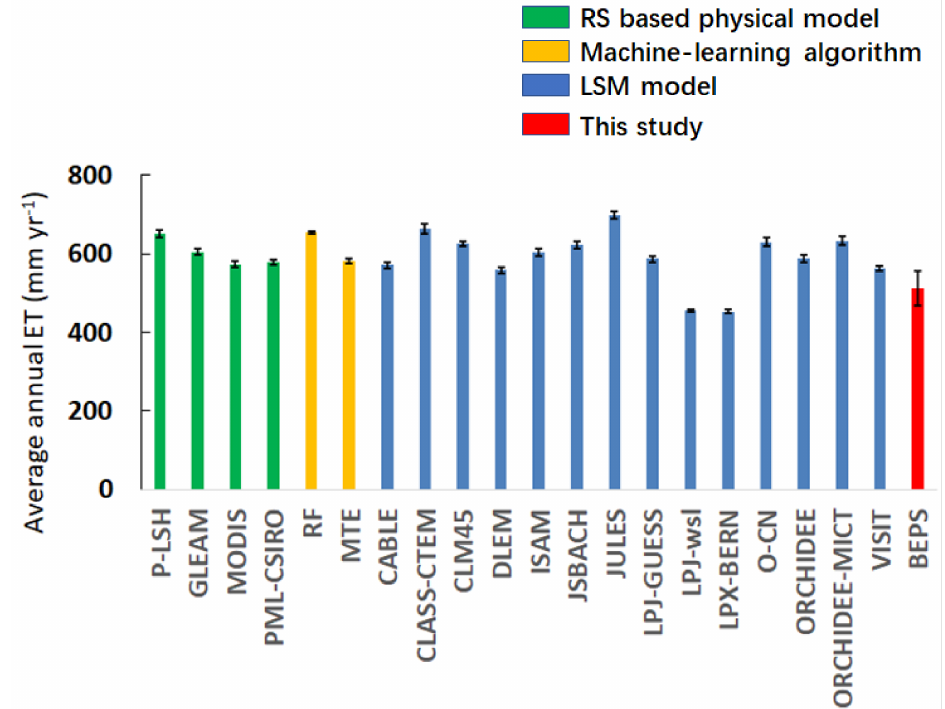
Figure 12. Average annual ET simulated by four remote sensings (RS) based physical models, two machine-learning algorithms, and 14 land surface models (LSM) during 2001 to 2011 and the BEPS model during 2013 to 2016 in this